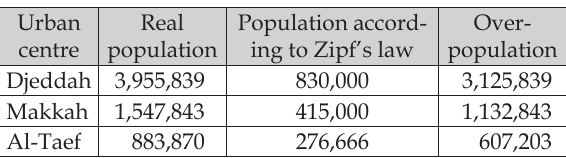
Table 4. Demographic plethora evaluation of the three first centres of Makkah’s urban